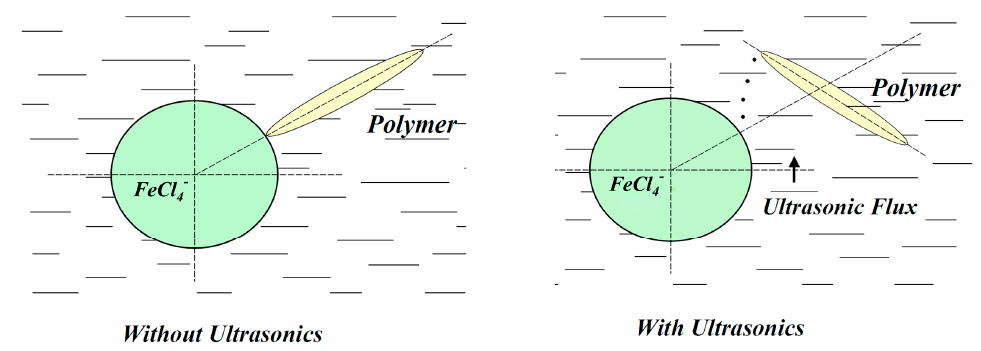
Figure 4. Diagram of the interaction of a protonated polymer molecule with an anionic iron complex under ultrasound conditions and without